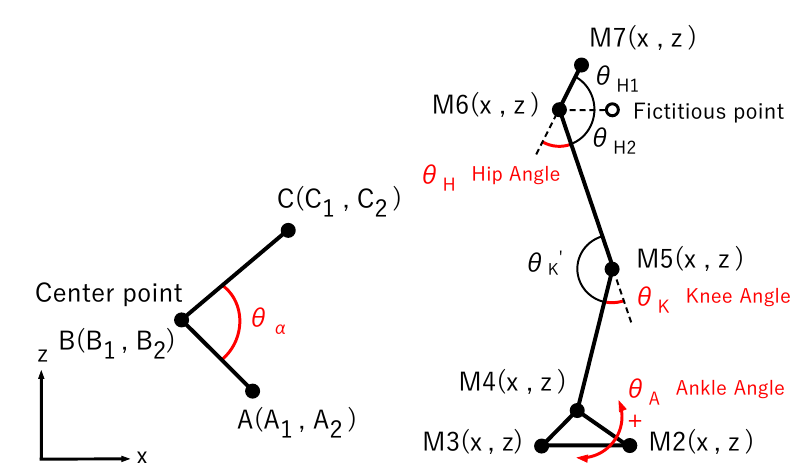
Figure 4. The range of motions (ROM) of the hip, knee, and ankle angle were calculated using the relative leg segments